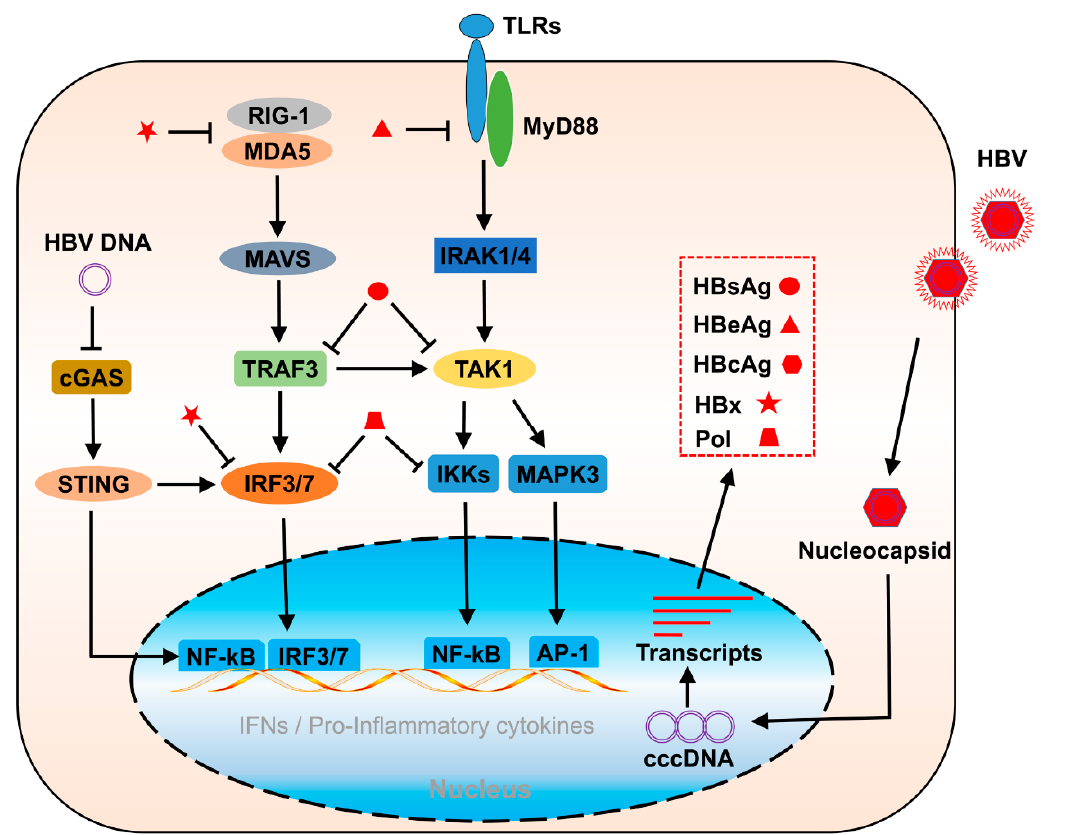
Figure 2. Schematic diagram of the inhibition of HBV protein in innate immunity and inflammation. HBx impairs IFN activation by inhibiting RIG-I and IRF3/7. HBeAg suppresses TLR-mediated innate immune response. HBsAg targets TRAF3 and TAK1, and HBV Pol targets IRF3/7 and IKKs, both of which lead to suppressive effects on the induction of ISGs and pro-inflammatory cytokines during HBV infection.